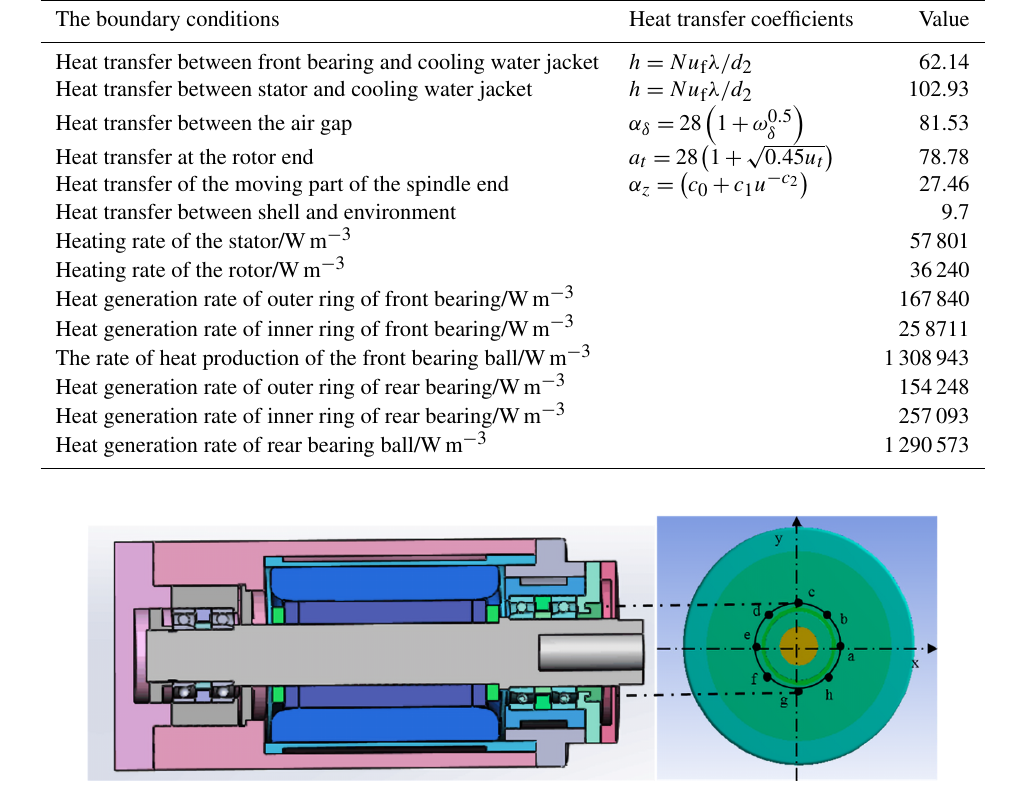
Figure 12. End circumference and measuring point distribution.